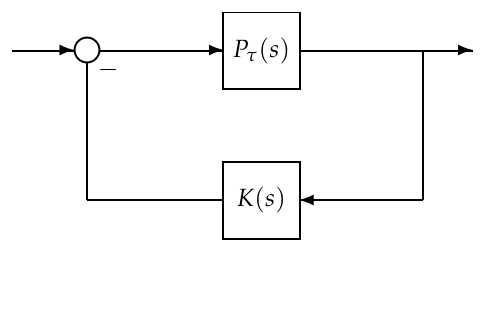
Figure 2. Feedback control